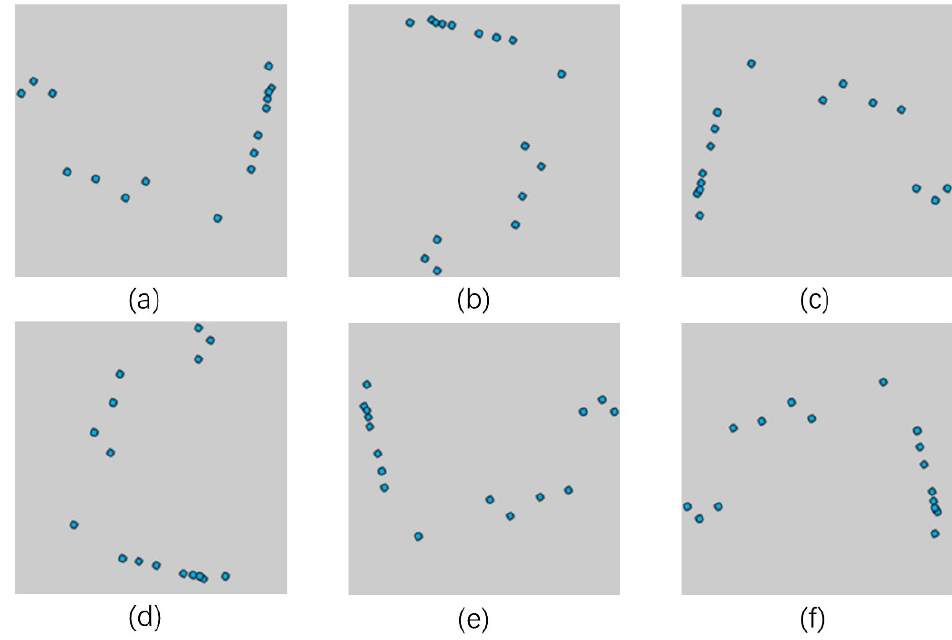
Figure 4. Data augmentation (DA) process. ( a ) Original image; ( b ) original image rotated 90° counterclockwise; ( c ) original image rotated 180° counterclockwise; ( d ) original image rotated 270° counterclockwise; ( e ) original image flipped horizontally; ( f ) original image flipped vertically.